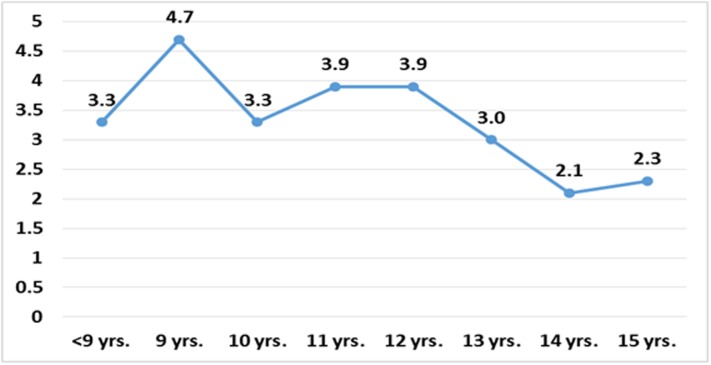
Age specific incidence of myopia (n = 8200).